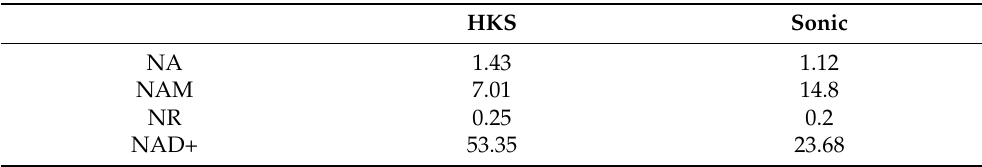
Table 1. Concentration of Niacin-related metabolites in cell preparation of Bifidobacterium breve